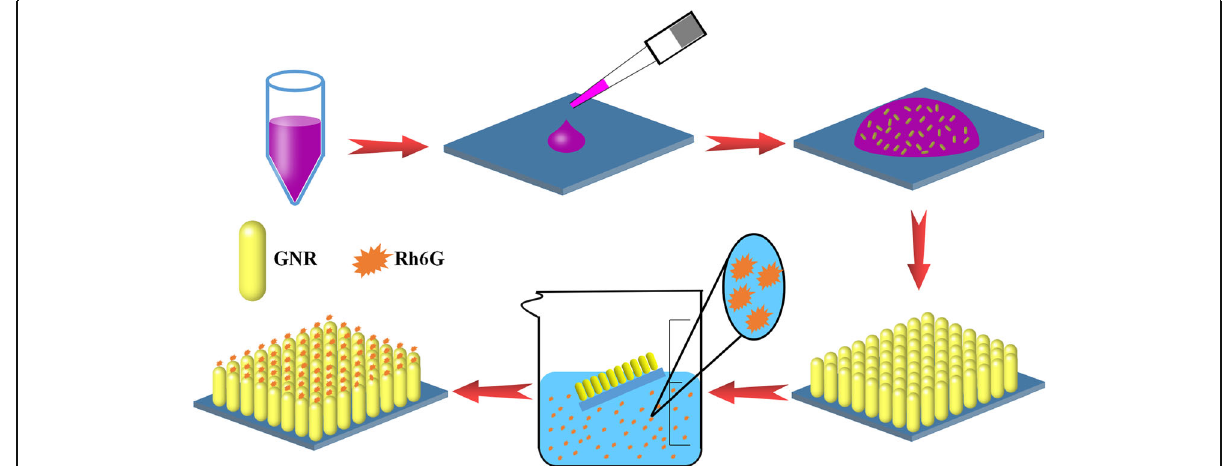
Fig. 1 The scheme of the preparation process of GNR vertical